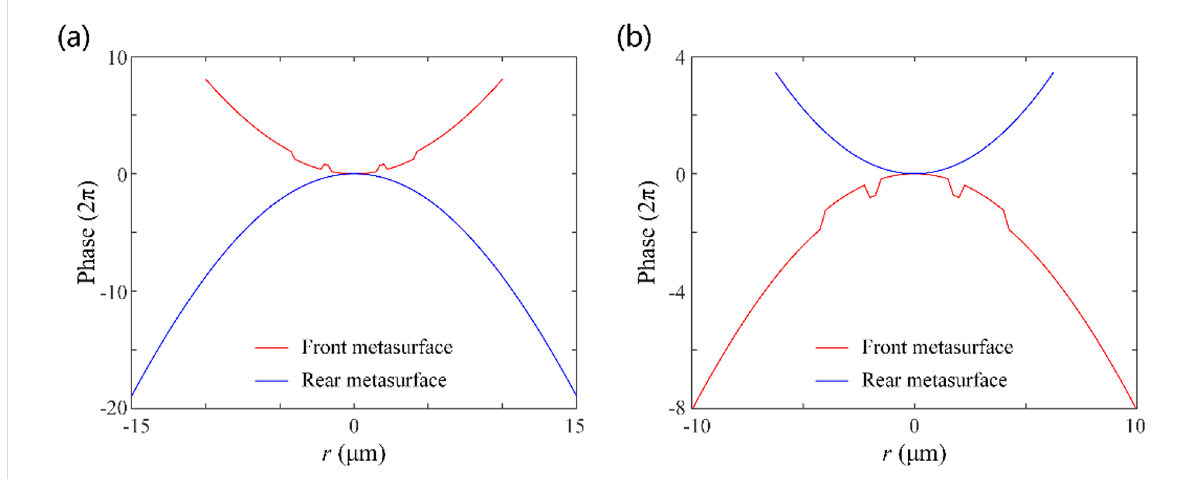
Figure 2: Phase profiles of the front and rear metasurfaces for (a) short and (b) long focal lengths.